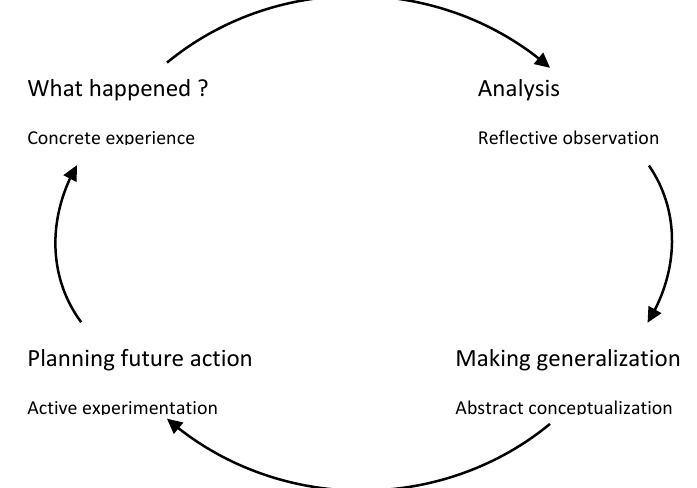
Figure 1. Kolb’s learning